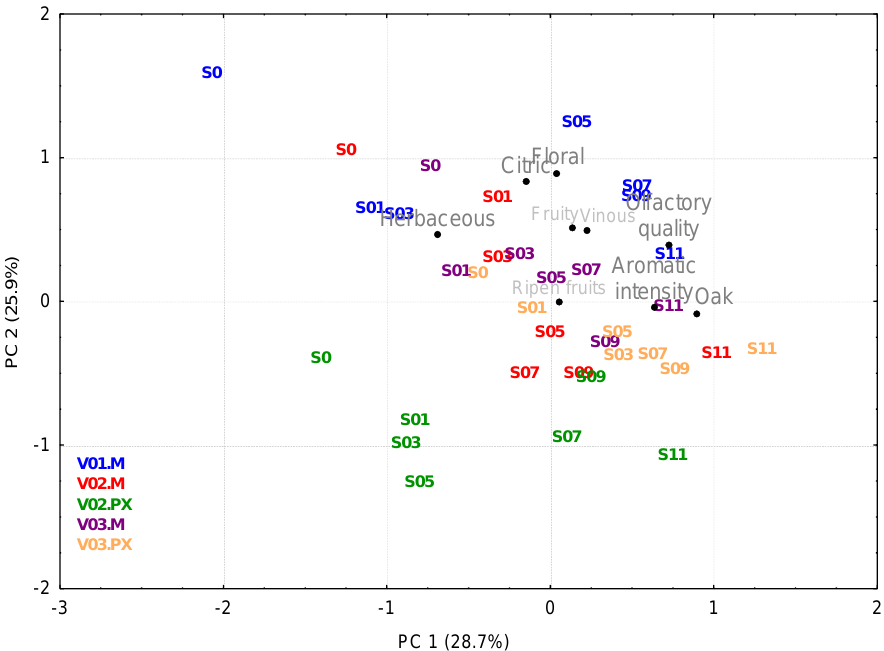
Figure 3. Principal components analysis of the sensory data of PX and Muscat wines from vintages V01, V02 and V03 fermented under the same conditions (E4) and aged for one year in oak barrels. Representation of both, the samples scores and the principal component loadings, onto the plane defined by the first two PCs.